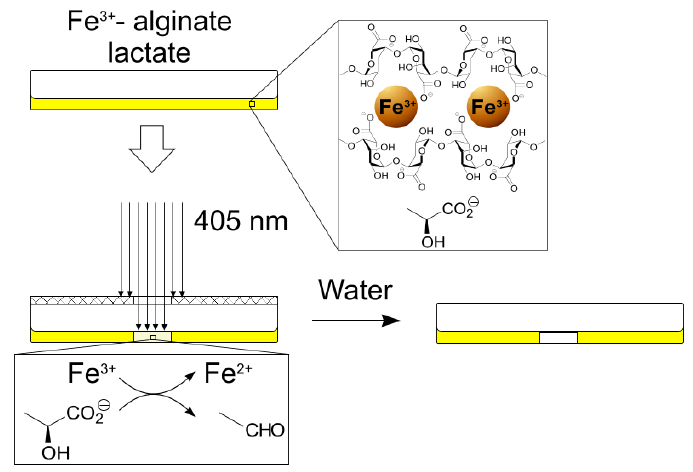
Figure 1. Scheme of spatially selective photoinduced dissolution of iron(III) cross-linked alginate gel containing sodium lactate by 405 nm light. Binding of iron(III) cations by guluronate residues of alginate is shown schematically in analogy to the egg-box model established for calcium cross-linked alginate